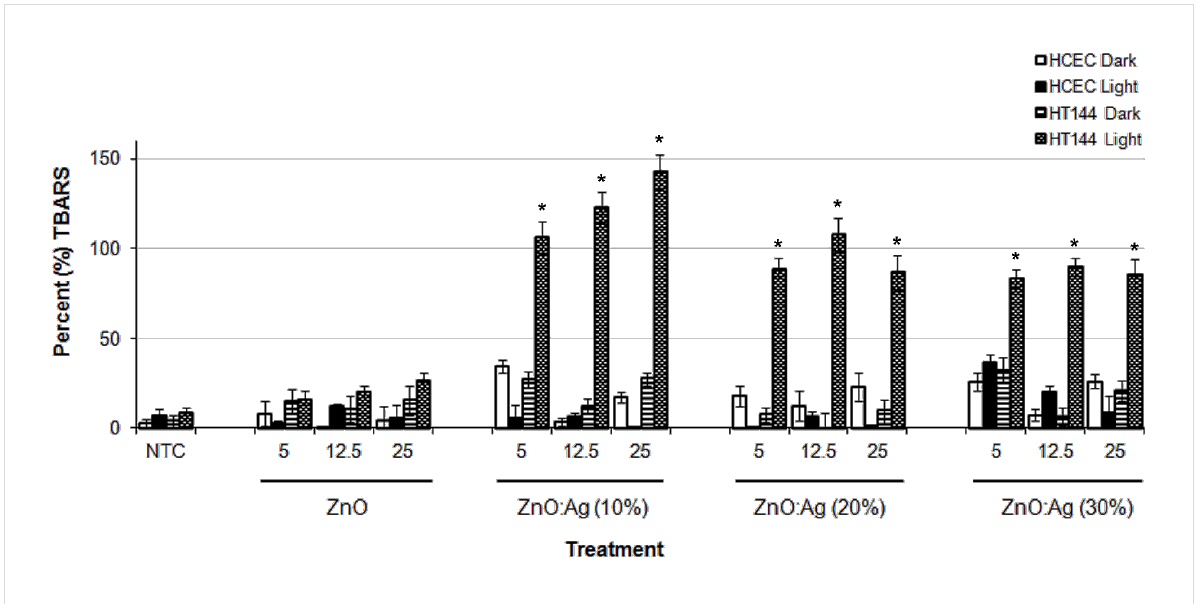
Figure 7: TBA assay results for nanoparticle exposure. Data is expressed as percent (%) TBARS (mean ± SD) relative to the NTC sample. * p < 0.0001 (two tailed t-test) when compared to HCEC dark, HCEC light and HT144